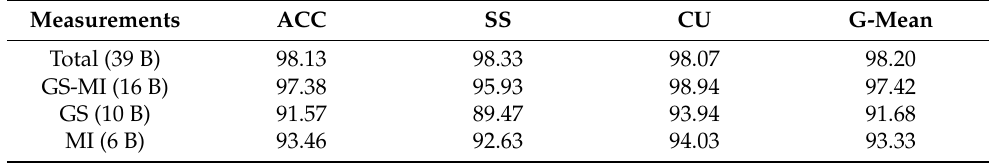
Table 9. RCNN performance metrics with measurements of generation and/or motor load buses.